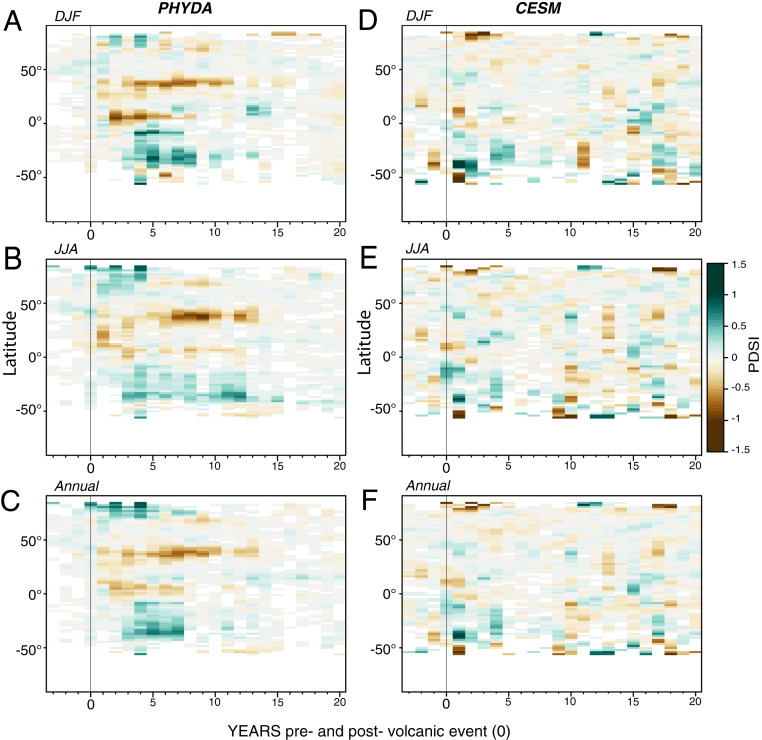
The Hovmöller diagram showing the weighted zonal mean response to TVEP or TVE in different seasons (A–C) using PHYDA and (D–F) CESM ensemble member 10, respectively. Values that do not satisfy the significance threshold (P < 0.05) are excluded. The vertical black line indicates the onset of the volcanic event. Greenland and Antarctica are not included.